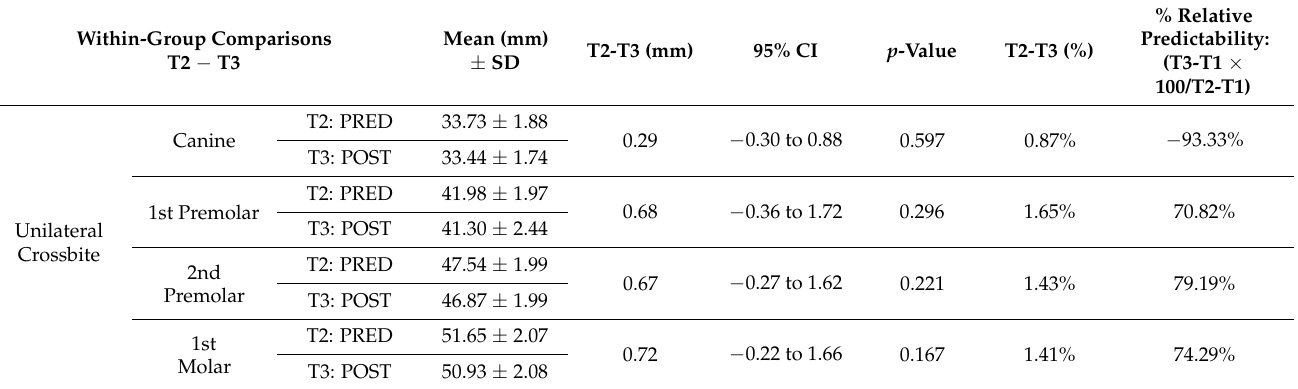
Table 4. Within-group comparisons of the predictability (T2-T3) of expansion at canine, premolar, and molar levels. T2: predicted final width; T3: observed final width post-treatment. T2-T3(%): percentage of final width not achieved by treatment. Relative predictability (%) calculated as observed versus predicted amount of expansion (T3-T1 × 100/ T2-T1). SD: standard deviation, %: percentage, CI: confidence interval, PRED: predicted, POST: post-treatment measure, T2: predicted outcome, T3: observed outcome, T1: baseline, mm: